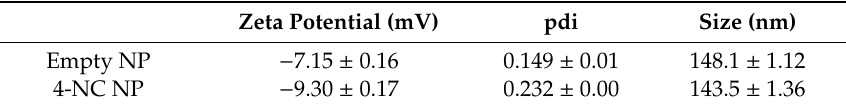
Table 1. Zeta potential, polydispersion index, and size of nanoparticles.